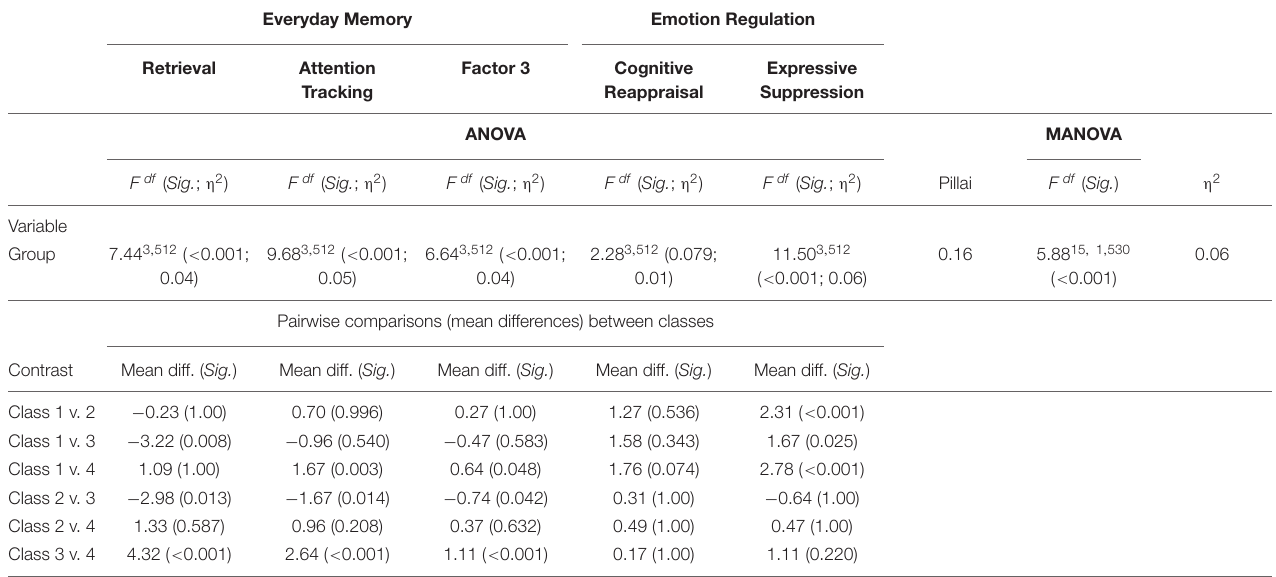
TABLE 4 | Latent profile effects on emotion regulation and everyday memory